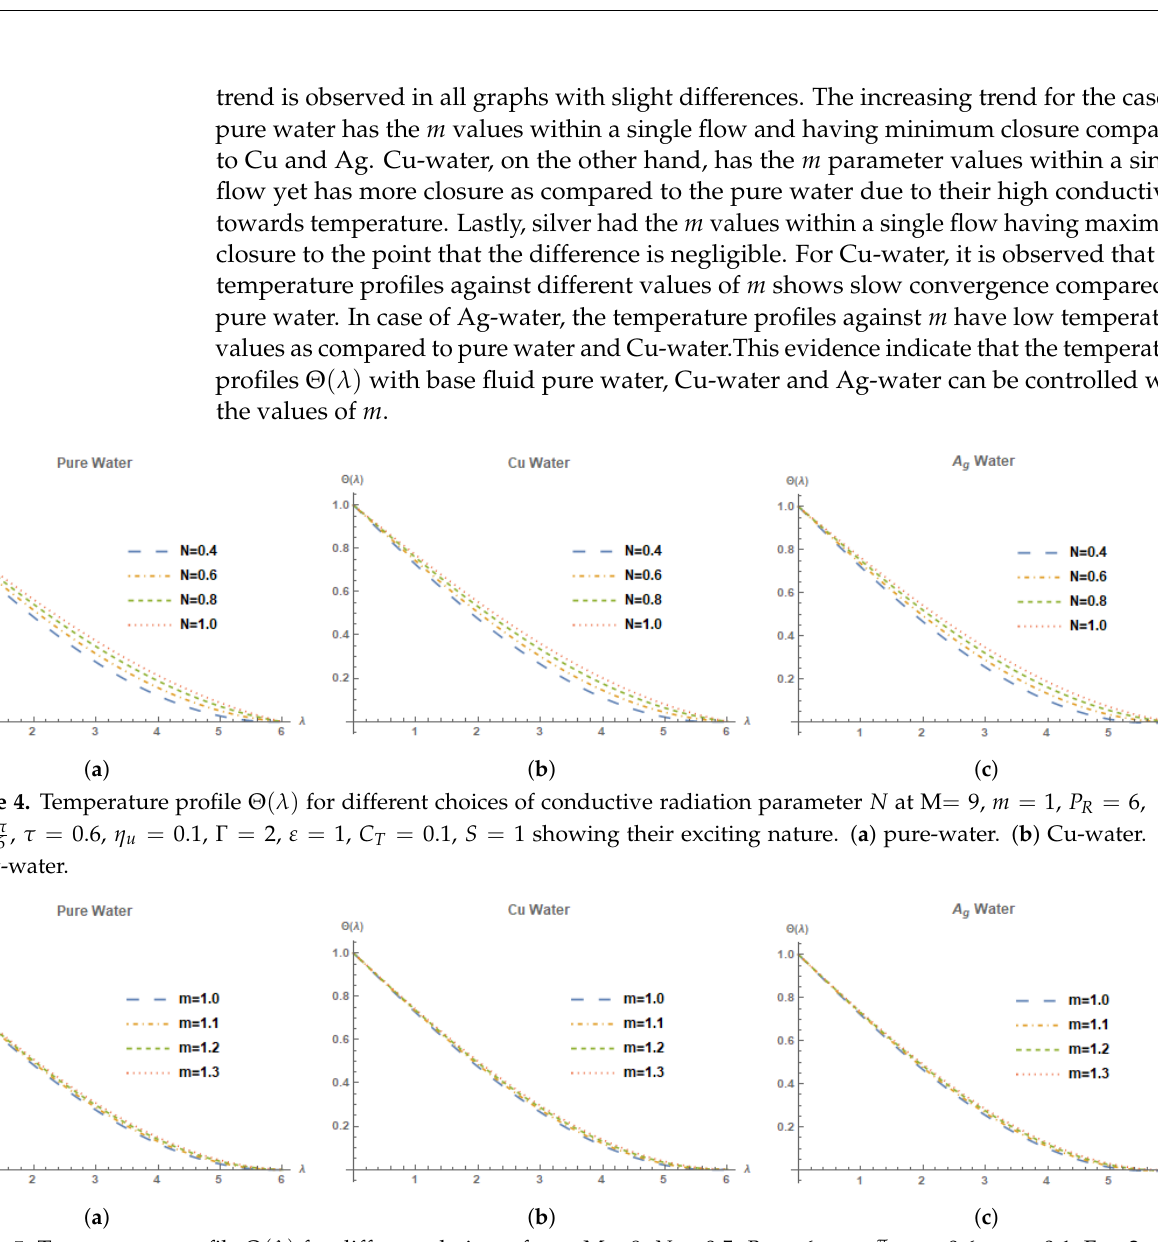
Figure 5. Temperature profile Θ ( λ ) for different choices of m at M = 9, N = 0.5, P R = 6, χ = π ε = 1, C T = 0.1, S = 1 showing their exciting nature. ( a ) pure-water. ( b ) Cu-water. ( c )